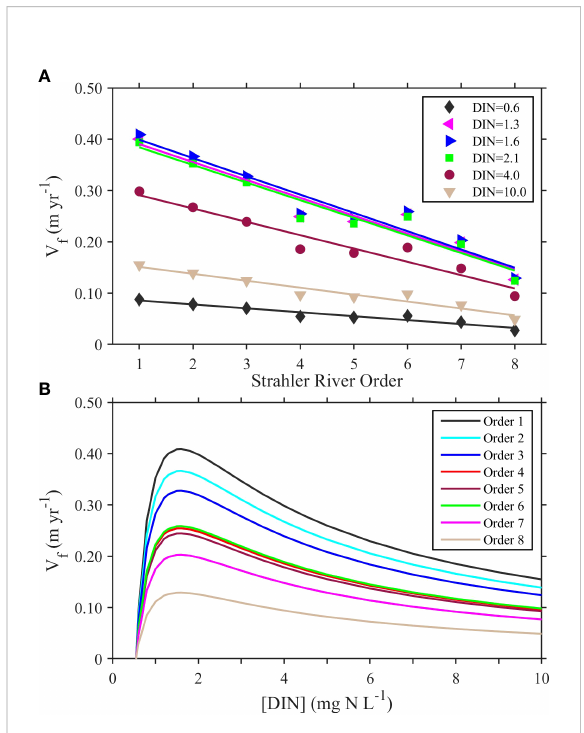
FIGURE 4 Relationships between V f and river order and [DIN] in the CRN. (A) Relationships between V f and Strahler river order at six given [DIN] (0.6,1.3, 1.6,2.1,4.0, 10.0 mg L -1 ); (B) V f in response to [DIN].